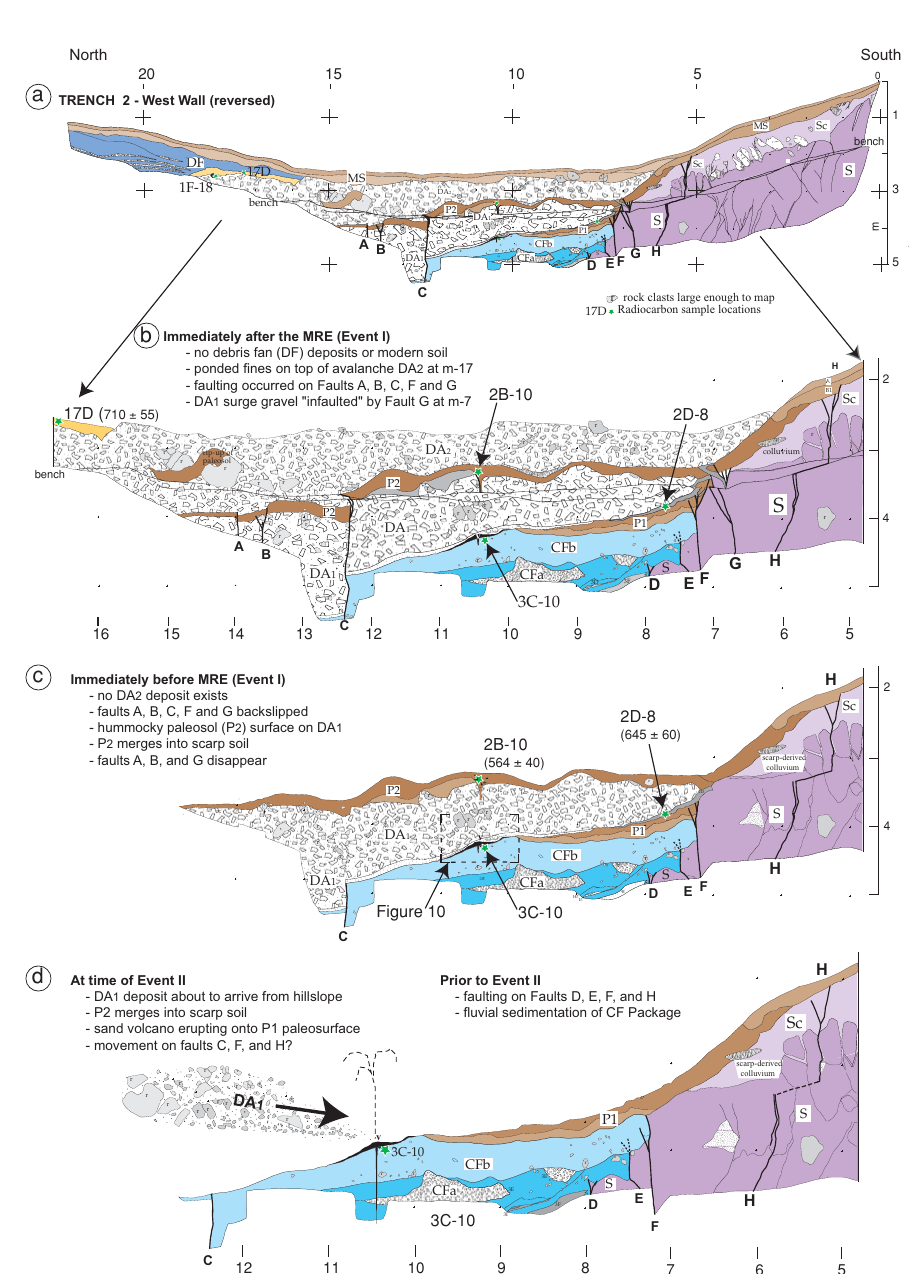
Fig. 9a-d. Sequence and explanation of retro-deformed logs of the west wall of Trench 2: a) the trench as logged; b) through d) show progressive unstripping of stratigraphy and removal of deformation. The area of fig. 10, including sandblow deposit (in black), is shown by a dashed box at metre-